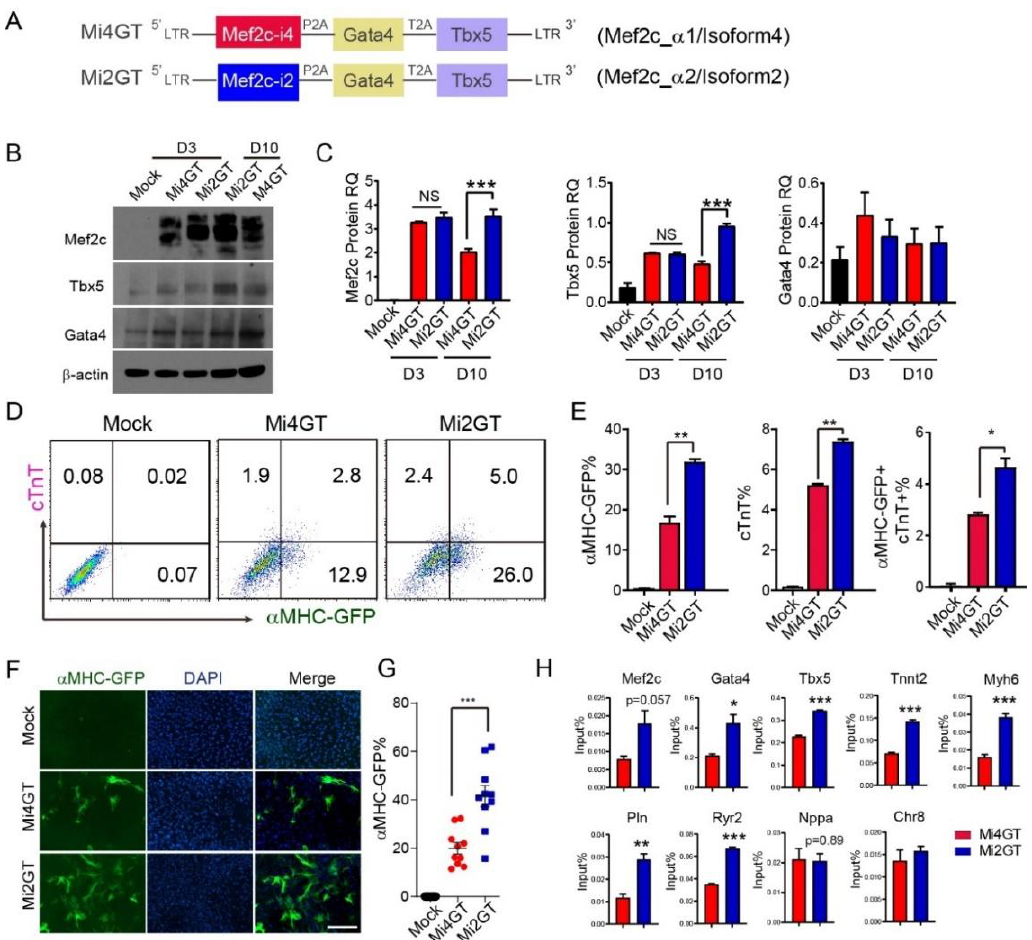
Figure 2. Mef2C isoform2 enhances iCM reprogramming in mouse embryonic cells (MEFs). ( A ) Schematic illustration of polycistronic constructs of Mi4GT and Mi2GT. ( B , C ) Western blot ( B ) and quantification ( C ) of M/G/T expression from Mi4GT and Mi2GT retrovirus infected MEF on day 3 and day 10. ( D ) Flow cytometry analysis and quantification ( E ) of iCMs generated from Mi4GT and Mi2GT